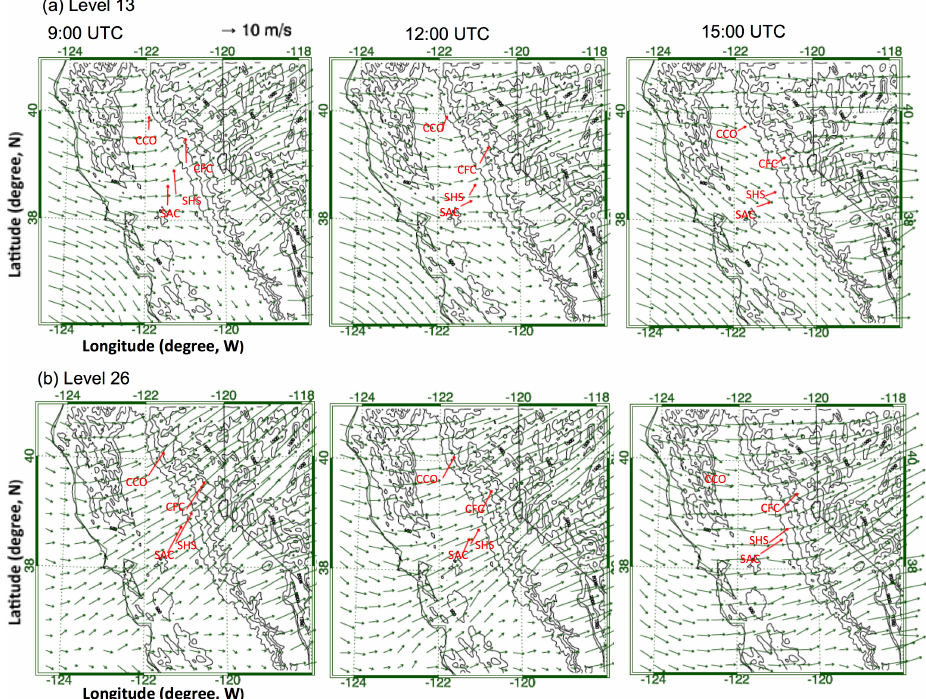
Fig. 13. Wind vectors at the model levels of (a) 13 ( ∼ 1km above terrain height) and (b) 26 (3km above terrain height) for FEB16 at 09:00, 12:00 and 15:00 UTC from the base run (LoCCN&Dust). The arrow above the first panel is the reference wind speed. The terrain height is denoted by the green contour lines with an interval of 500m from 0 to 2000 m. The red arrows denote the measurements from four wind profilers that are located at the stations of CCO (Chico, California), CFC (Colfax, California), SHS (Sloughhouse, California), and SAC (Sacramento,